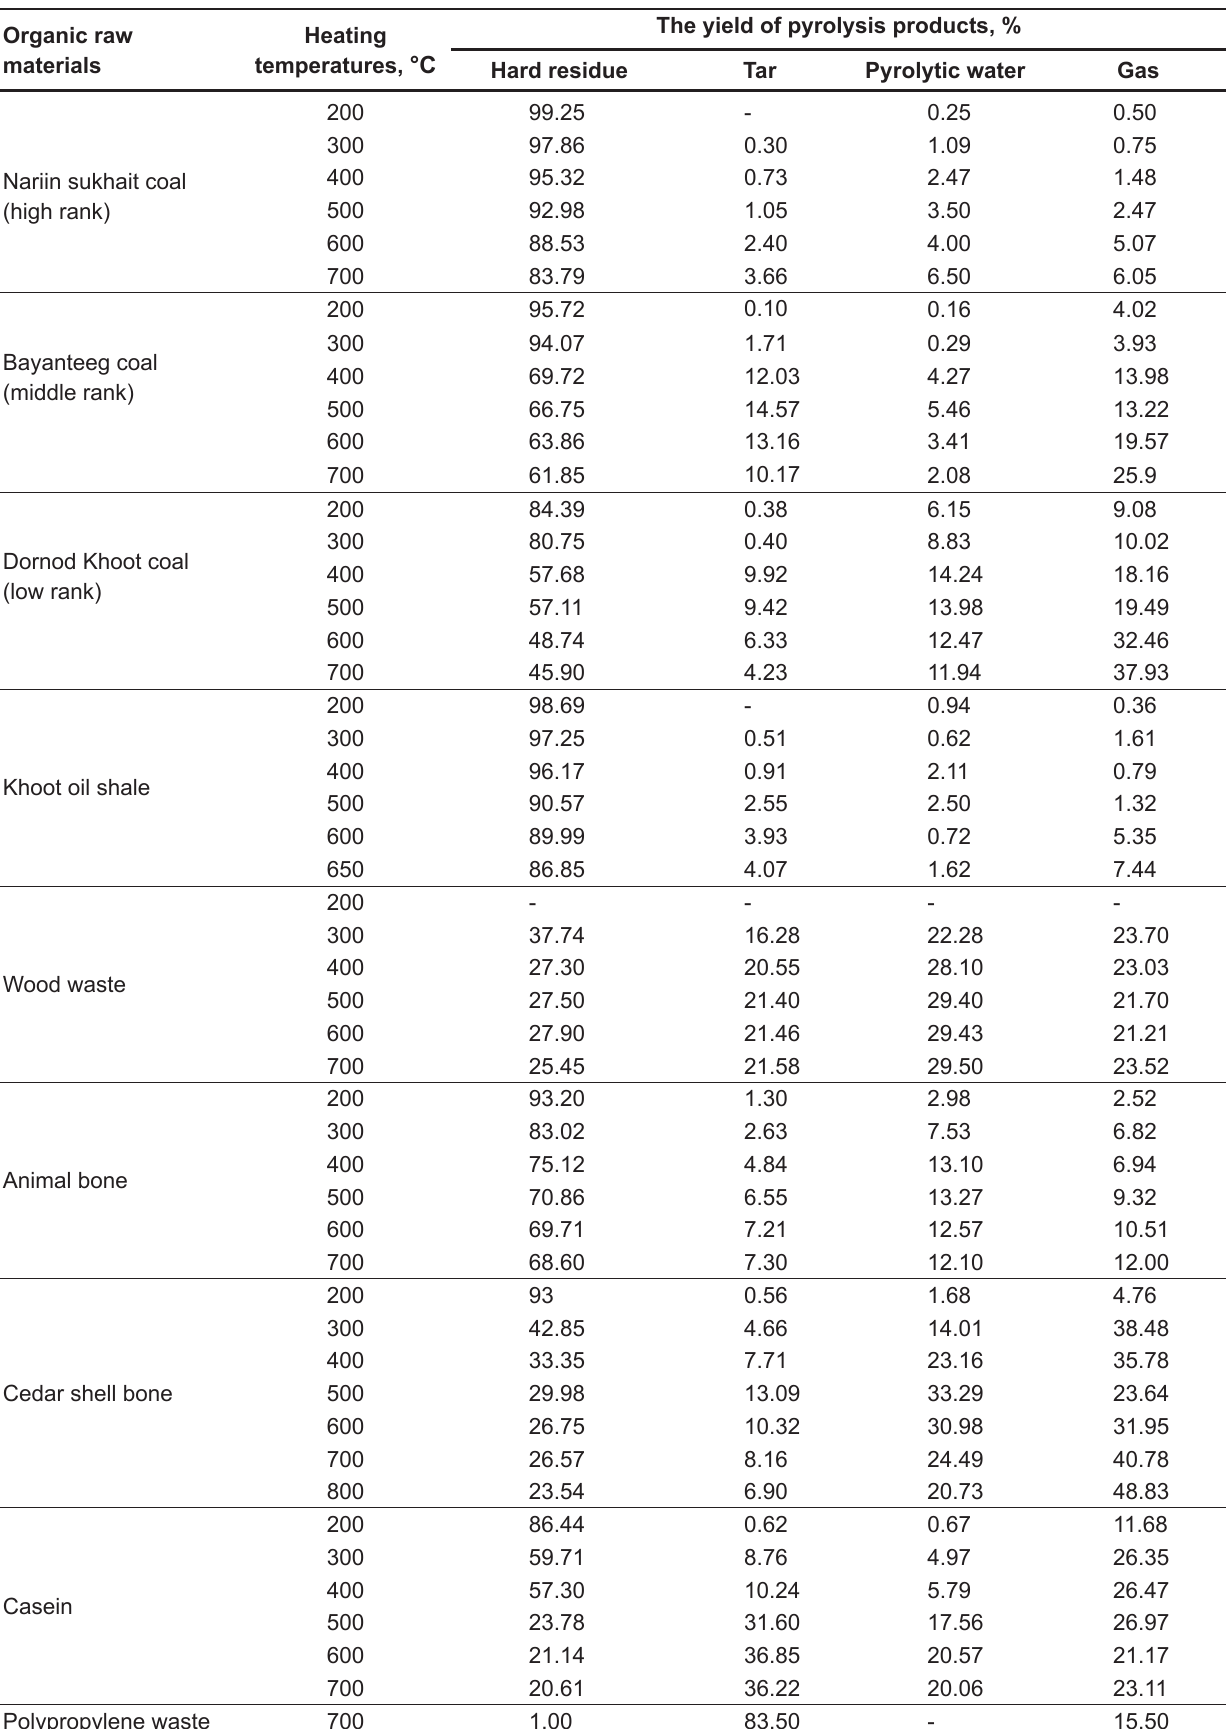
Table 3. The yields of pyrolysis products of organic raw materials at different heating temperatures Organic raw